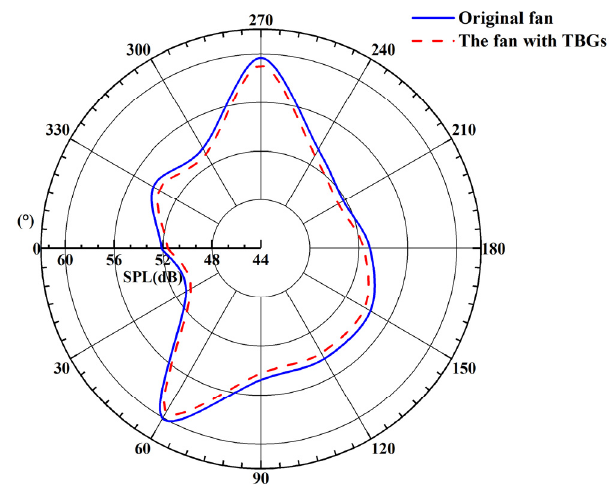
Figure 20. Noise results of original fan and the fan with TBGs.